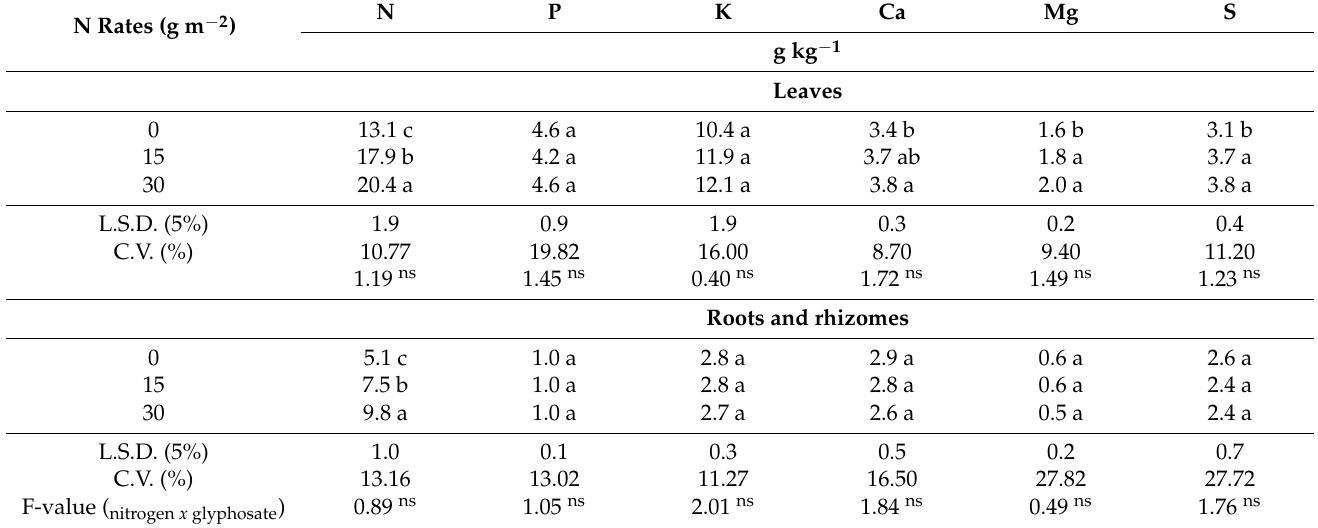
Table 2. The macronutrient concentrations of the leaves, roots and rhizomes of the emerald grass as a function of nitrogen fertilization in the 10th